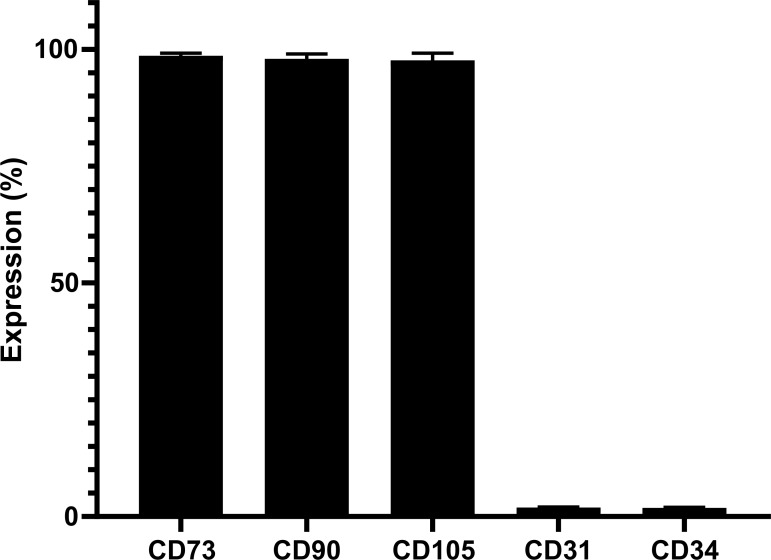
Flow cytometry analyses of UCMSC surface markers.Fluorescently-labelled antibodies were used to detect CD73, CD90, CD105, CD31, and CD34 expression levels by flow cytometry. The results indicated the genuine MSC character expected for cells derived from umbilical cord (UC). Error bars indicate standard deviation.